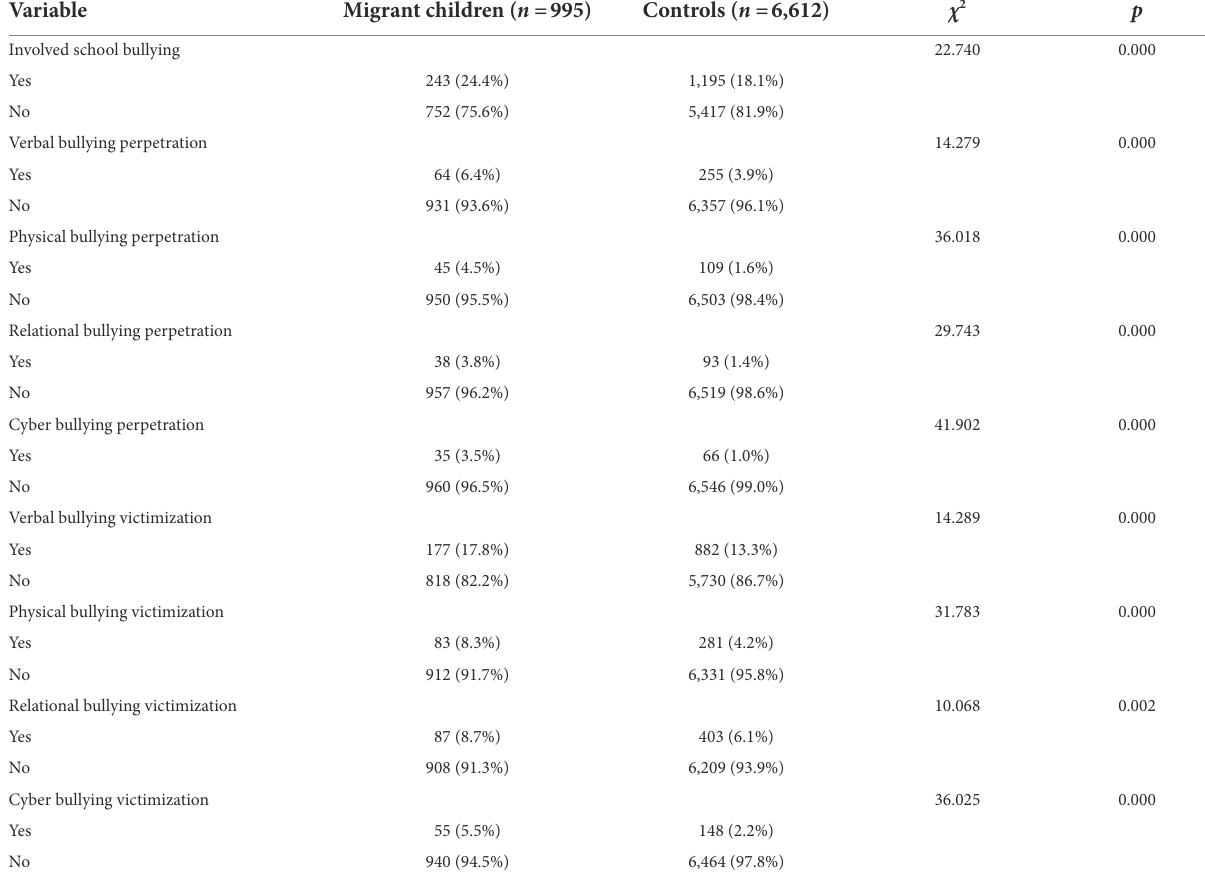
TABLE 2 Migrant children and non-migrant children comparison of school